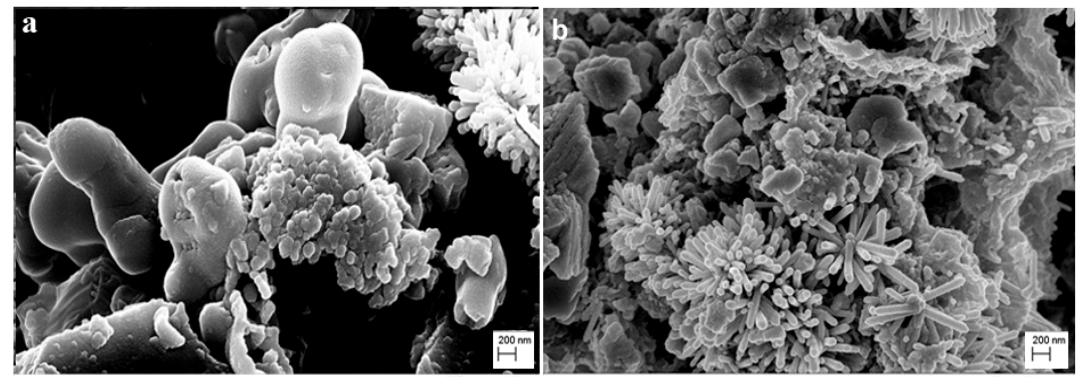
Figure 7. FE-SEM micrograph of A. aurescens TC4 cells after exposure to Noto stone covered with ZNGs. Panel ( a ), bacterial cell after 24 h exposure; Panel ( b ), brick covered by ZNGs. Bar, 200 nm.